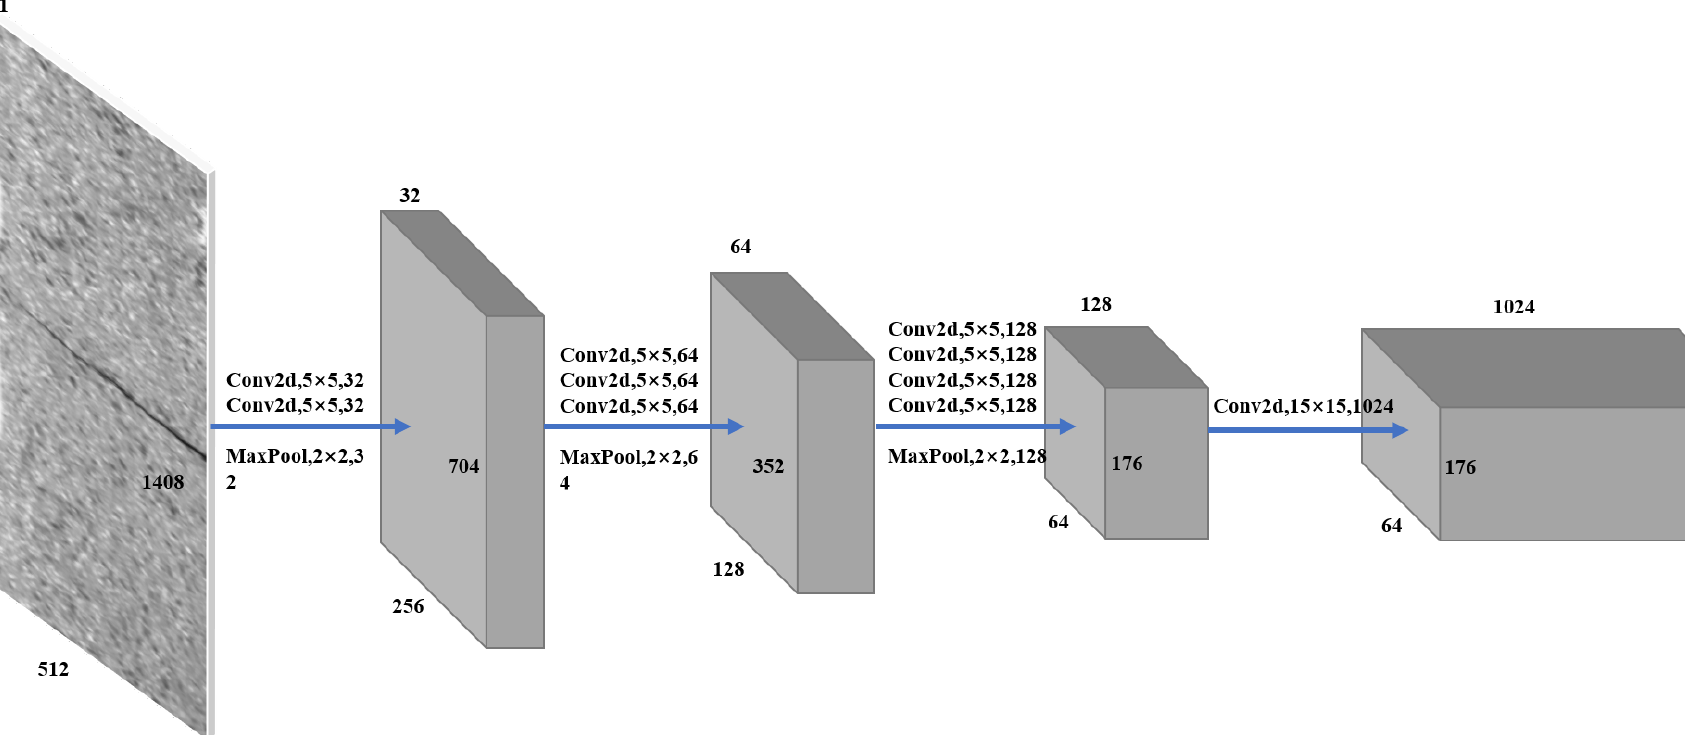
Figure 3. Structure of feature extraction